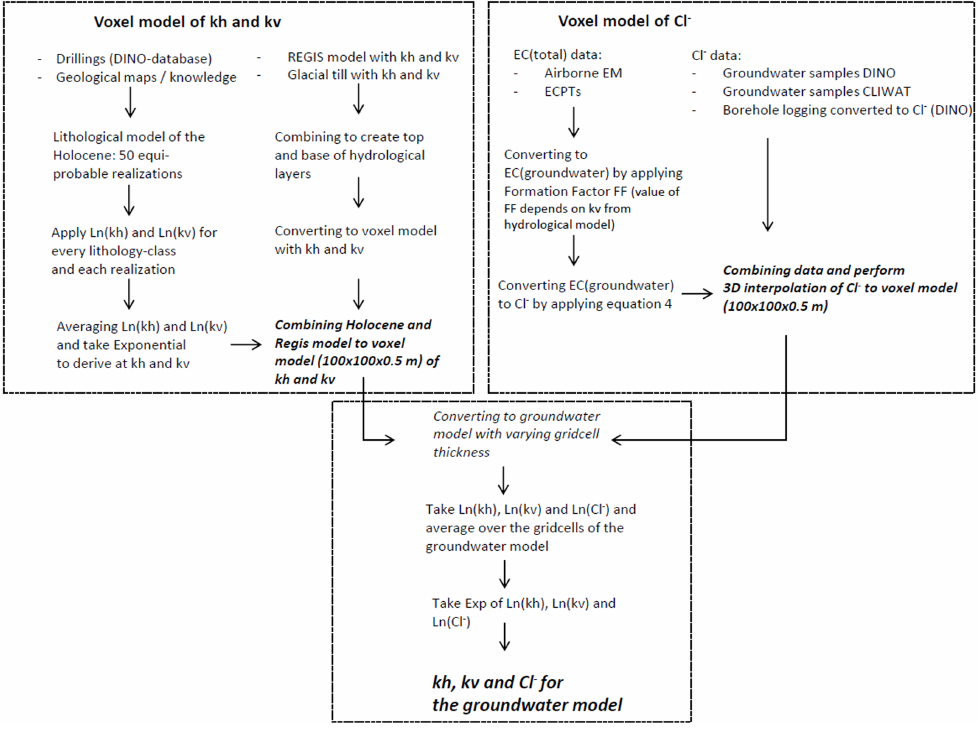
Fig. 11. The flow of data and interactions for deriving vertical and horizontal hydraulic conductivities and chloride concentration for the groundwater